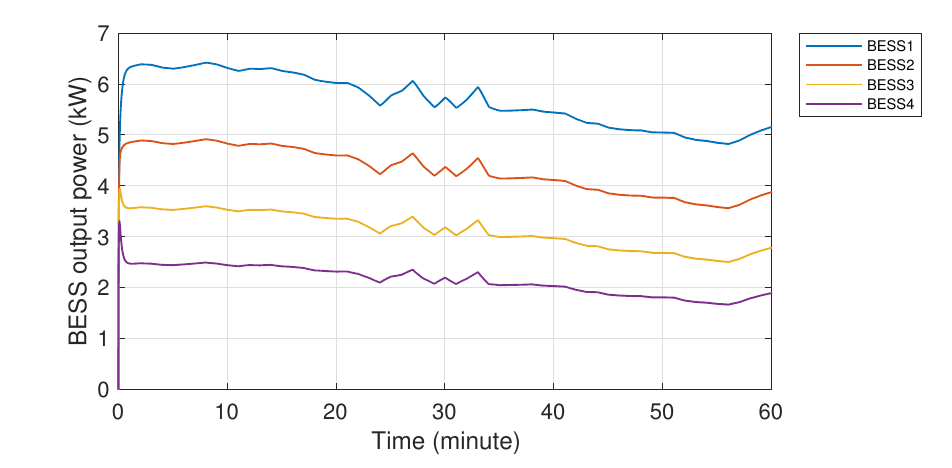
Figure 20. BESSs’ active powers.